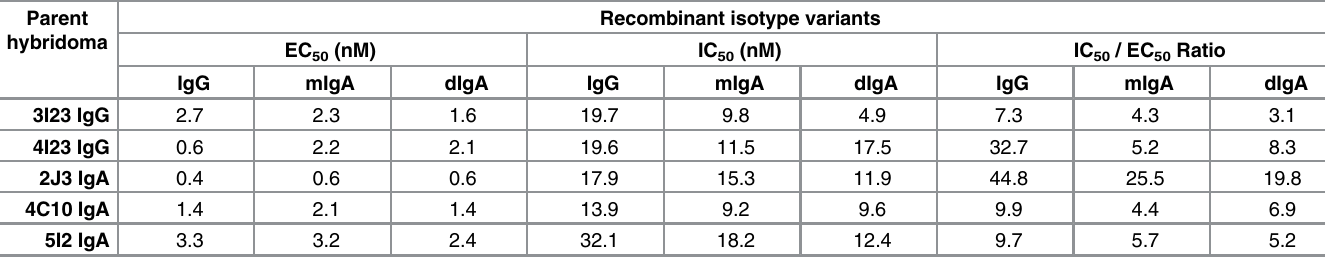
Table 1. Blocking potencies of various isotypes of anti-NV mAbs. Parent